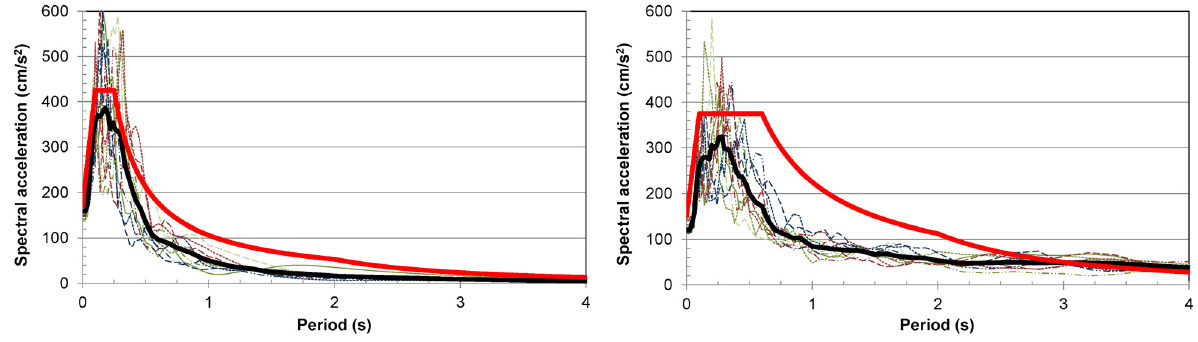
Figure 11. Response spectra for the 10 seismic motions computed for each source: (left) near-field seismic motion; (right) far-field seismic motion. The mean of the 10 spectra are presented in bold (black curve). Bold red curve: Portuguese seismic code response spectra for 475 year return